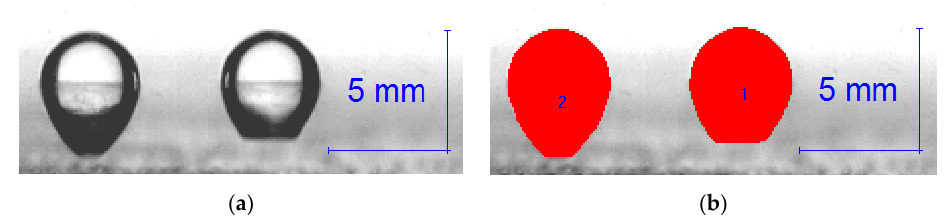
Figure 4. Area of interest (AOI) of bubble: ( a ) Photograph taken by high speed camera; ( b ) Image processed by Image-Pro Plus (IPP) software.